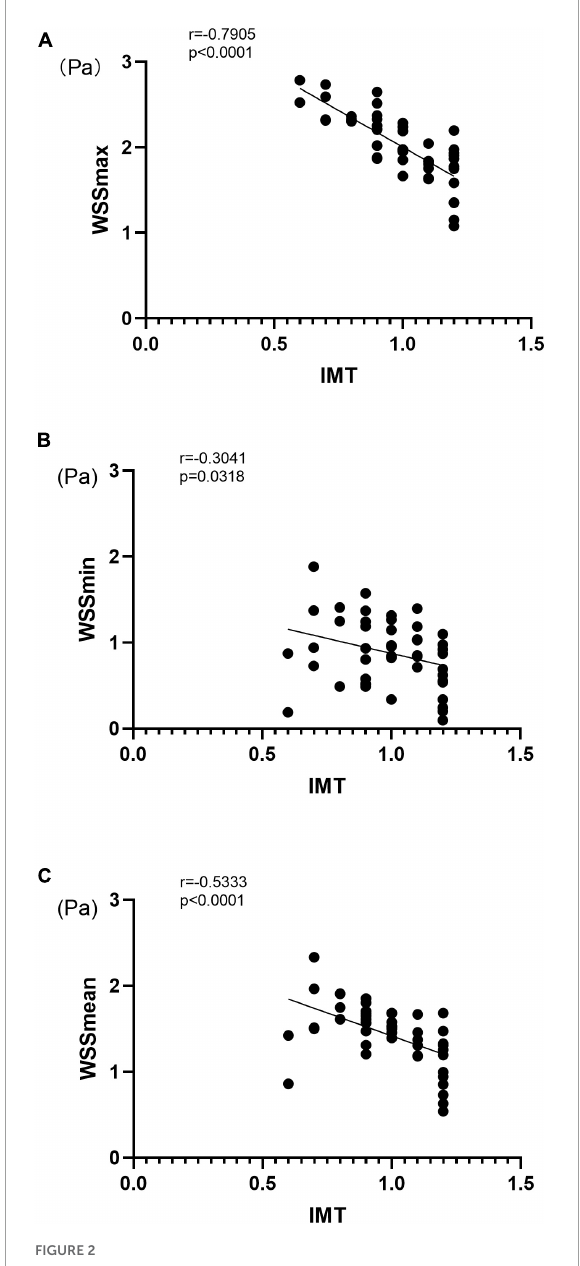
FIGURE2 Correlation between carotid artery VFM-based WSS parameters and IMT for WSS max (A) , WSS min (B) , and WSS mean (C) . IMT, intima-media thickness; WSS, wall shear stress; r, Spearman’s correlation